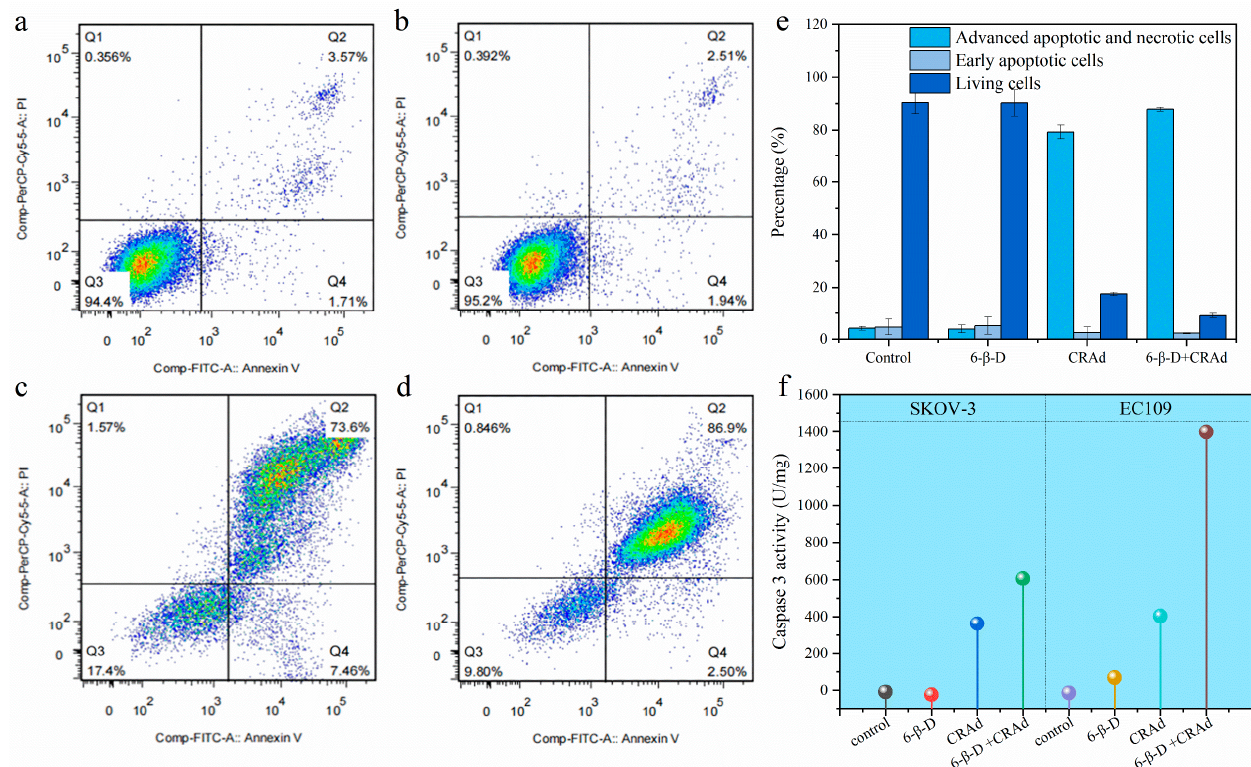
Figure 5. Effects of CRAd on Caspase-3 activity and cellular apoptosis. CRAd-induced cellular apoptosis detected by flow cytometry. ( a ) Control: EC109 cells; ( b ) 6- β -D-treated EC109 cells; ( c ) CRAd-treated EC109 cells; ( d ) 6- β -D- and CRAd–treated EC109 cells; ( e ) Quantitative analysis of cellular apoptosis; ( f ) CRAd stimulated Caspase-3 activity in EC109 and SKOV-3 cells.